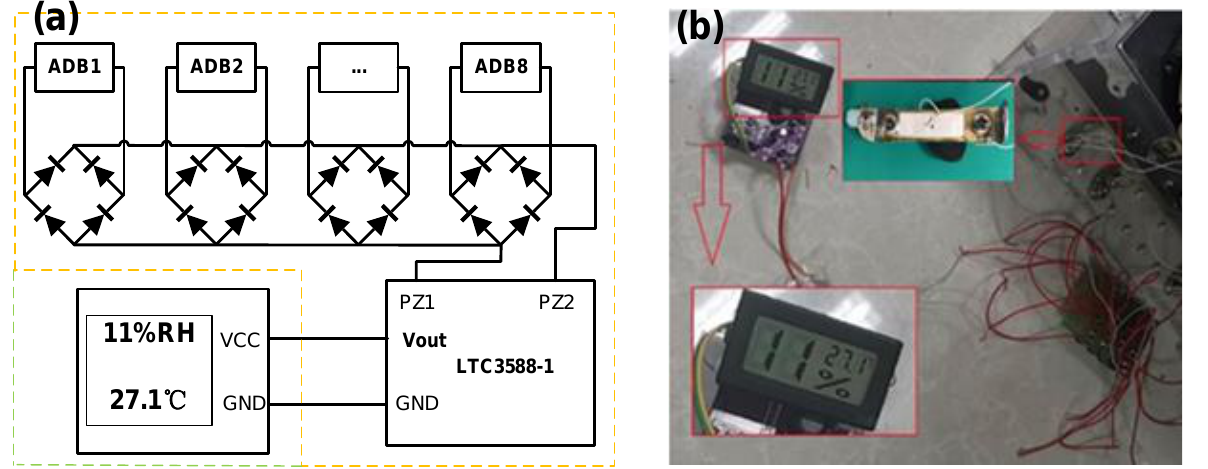
Figure 11. Applying proposed PPEH in powering a low-power sensing device. ( a ) Circuit diagram of the system; ( b ) Picture of the powered sensing